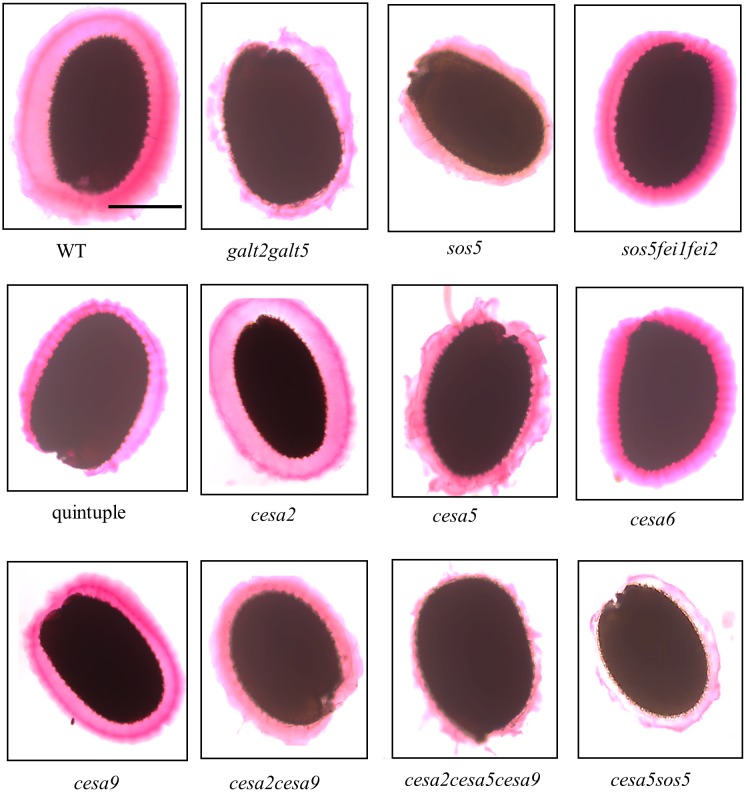
Aberrant adherent mucilage structure in the mutants as depicted by ruthenium red staining.Ten milligrams of WT and mutant seeds were hydrated in water and occasionally shaken prior to ruthenium red staining. Scale bar = 0.2 mm.